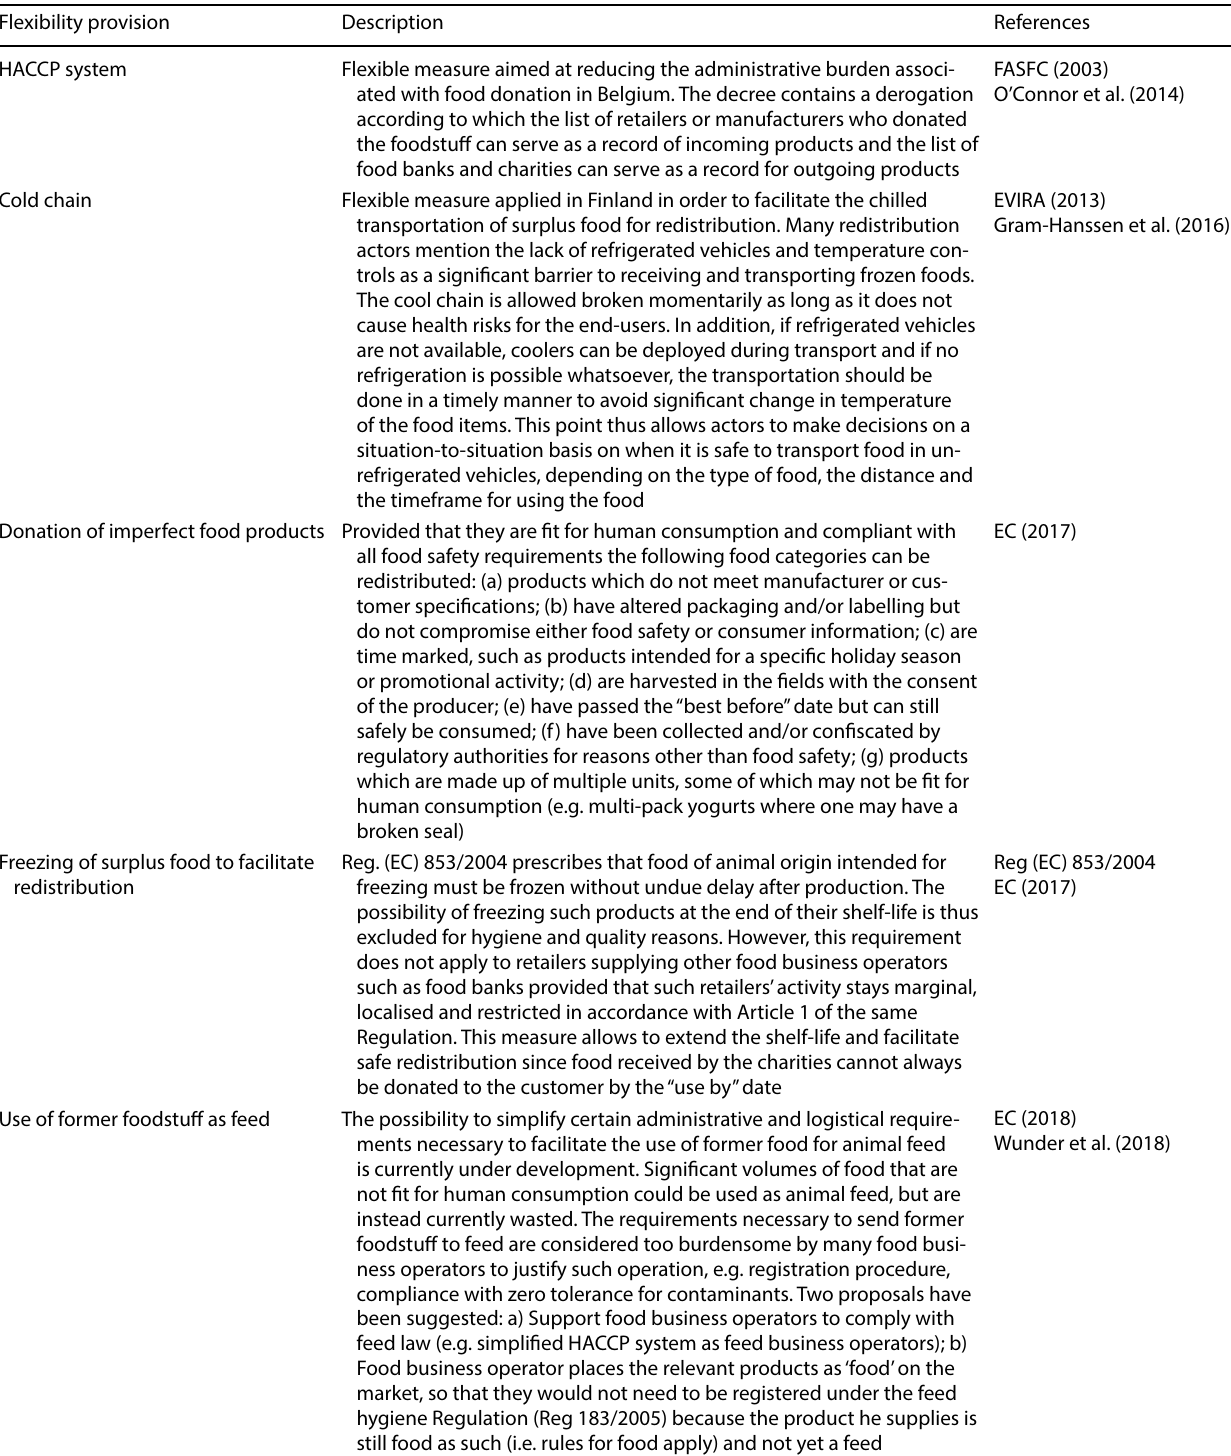
Table 3 Examples of flexible measures to reduce food